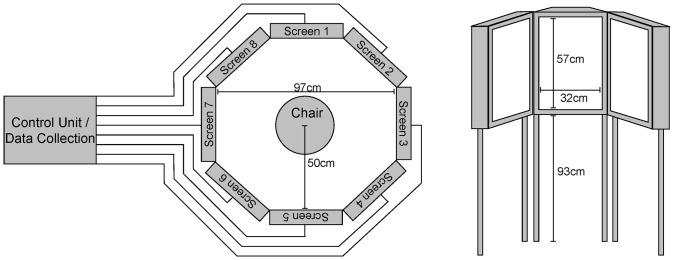
Schematical drawing of the CM.